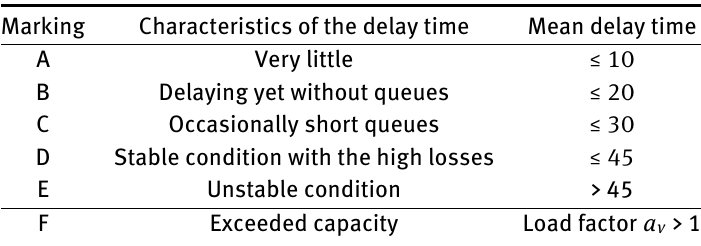
Table 8: Assessing the transport quality. Source: authors.